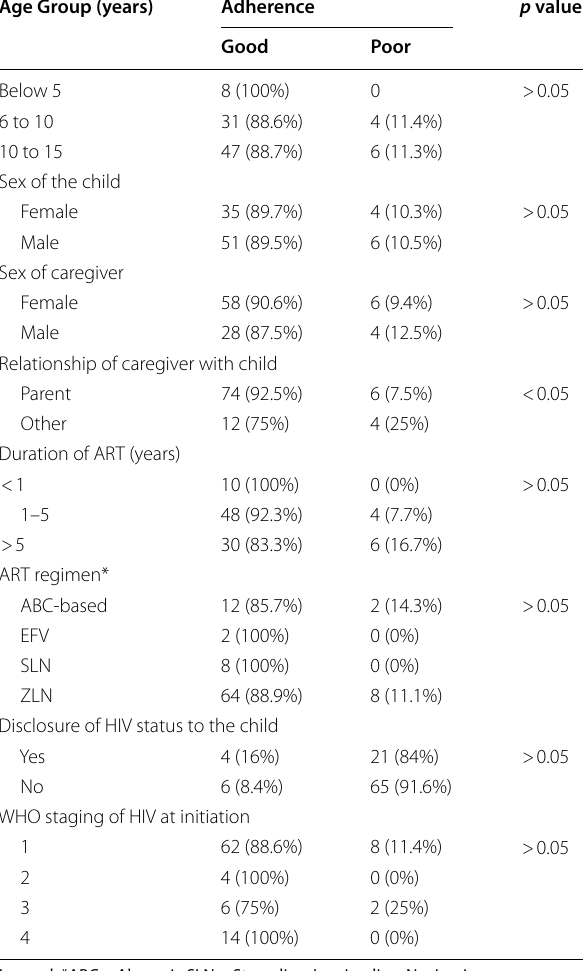
Table 2 Table showing demographics of children and caregivers involved in the study Age group (patient) (yrs.)